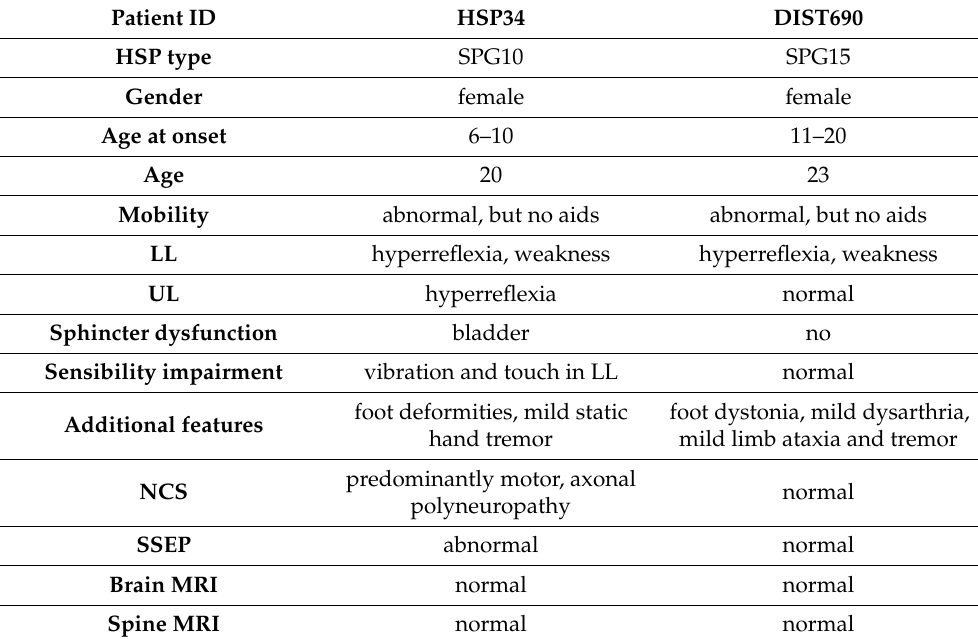
Table 6. Clinical findings in patients with genetically confirmed SPG10 and